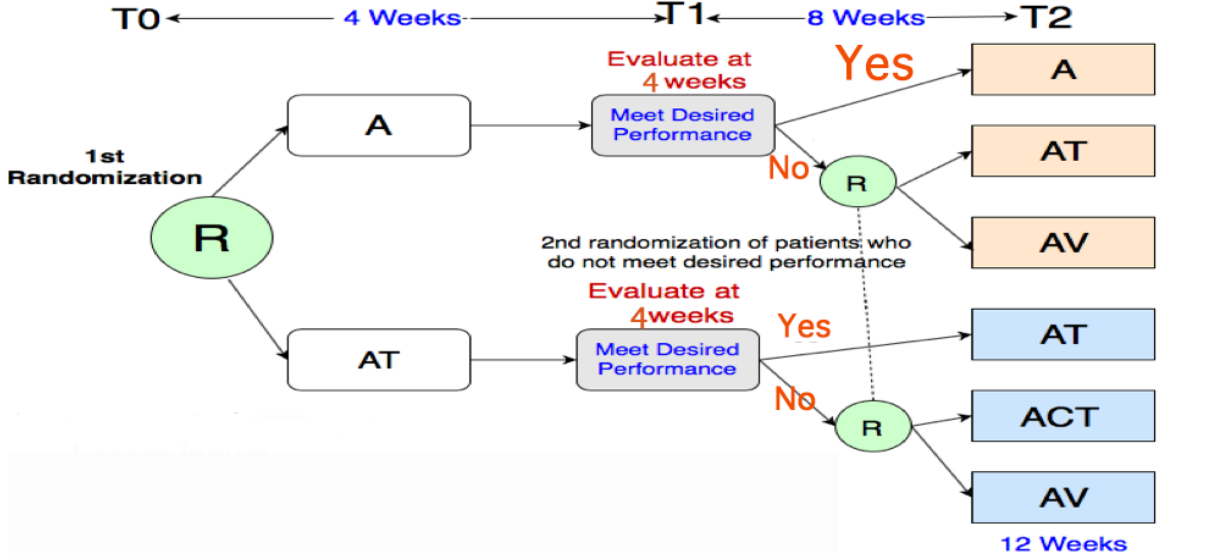
Figure 1. Study design. The participants are randomized first at R: one group uses only the app (A) and another group is given the app with medication information text (AT). At time point 1 (T1), after 4 weeks, both groups are evaluated for information recall (>80%). Then, after a second randomization (R), the participants are divided into the following groups: app with medication information text (AT), app with contextual medication information text (ACT), and app with visualization (AV). T0: baseline; T2: time point 2 (after 12